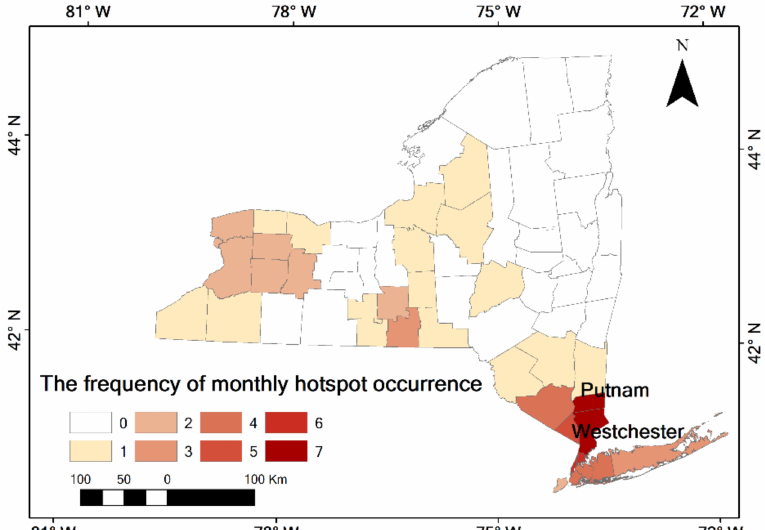
Figure 3. Occurrence of COVID-19 hot spots in New York State from March to December